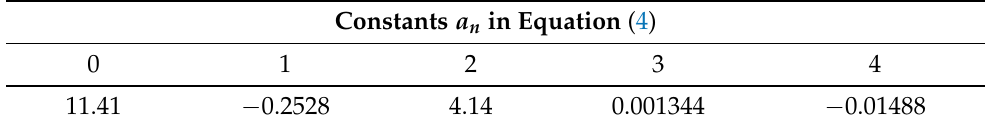
Table 2. Constants for Equation